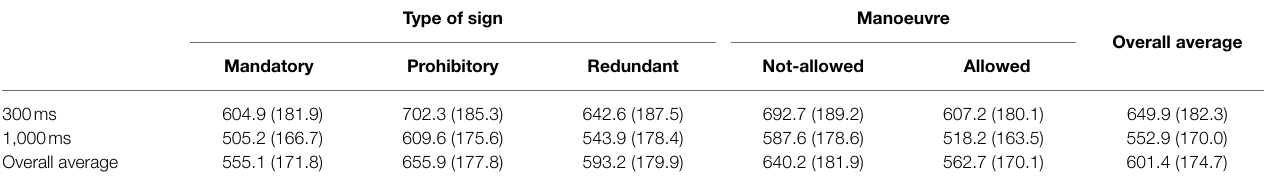
TABLE 1 | Mean correct RTs (ms) and SDs (in parentheses) for each main effect in Study 1.